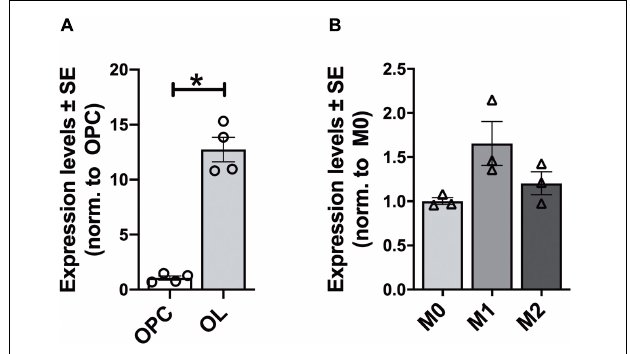
FIGURE 9 | Gene expression analysis of Elovl5 in glial cells. (A) Elovl5 expression in oligodendrocytes (OL, n = 4) compared to immature oligodendrocyte precursor cells (OPC, n = 4) ( P < 0.05 Mann-Whitney U -test). (B) Elovl5 levels in microglial cells in resting (M0, n = 3), proinflammatory M1 phenotype ( n = 3) and proregenerative M2 phenotype ( n = 3). The expression levels were compared to the microglial cells in resting state. * P < 0 .